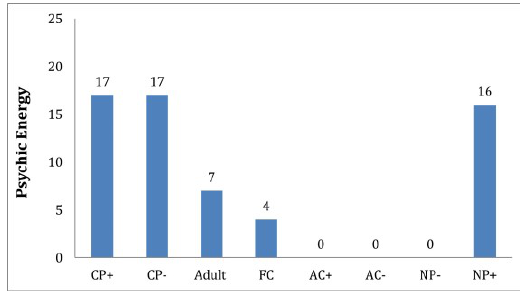
Chart 6: Egogram Teacher 3 with Student 2